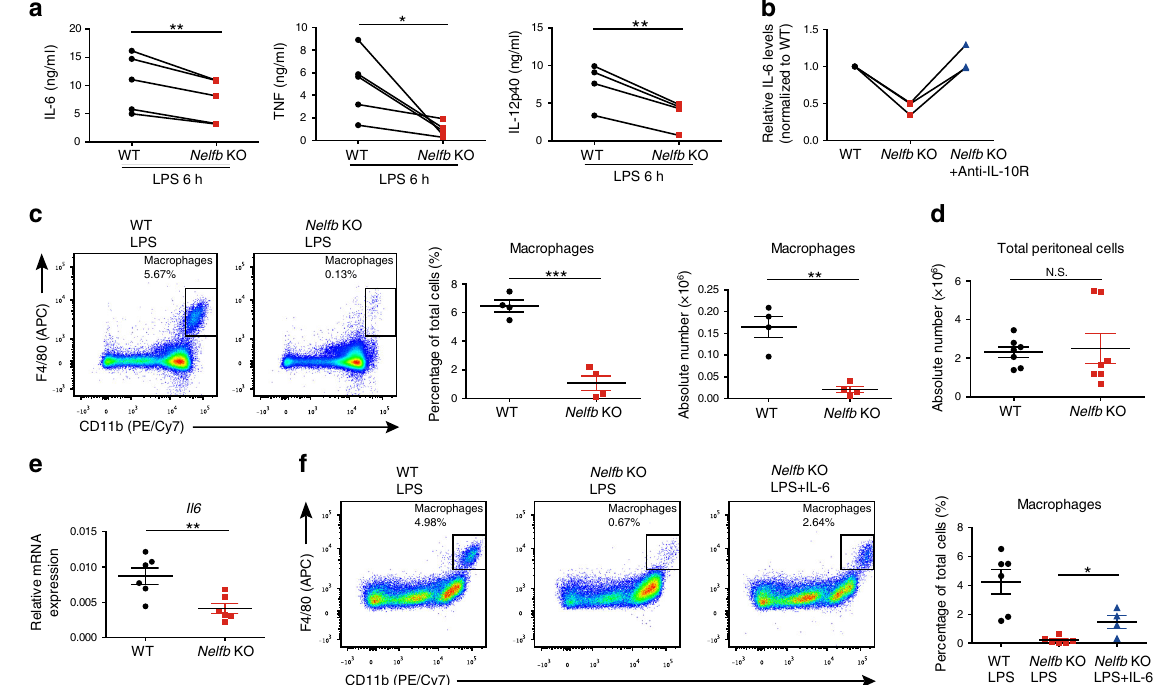
Fig. 7 NELF potentiates in fl ammatory responses secondary to constraining the production of IL-10. a ELISA for IL-6 ( n = 5, P = 0.0051), TNF ( n = 5, P = 0.0402) and IL-12p40 ( n = 4, P = 0.0061) protein levels in WT and Nelfb KO BMDM stimulated with LPS for 6 h. * P < 0.05, ** P < 0.01 by two-sided paired Student ’ s t test. b WT and Nelfb KO BMDM pretreated with 2 μ g/ml of anti-IL10R for 0.5 h, where indicated, were activated with LPS for 6 h. IL-6 levels in culture supernatants were measured by ELISA and shown as relative values normalized to levels in WT cells that were set as 1 in each independent experiment ( n = 3). c FACS analysis of the macrophage population (CD45 + CD11b + F4/80 + ) in peritoneal exudates of WT and Nelfb KO mice 9 h after intraperitoneal injection of LPS (100 ng/mouse). Representative FACS distribution (left) and cumulative ( n = 4) percentage (middle, P = 0.0002) as well as absolute numbers (right, P = 0.0014) are shown. d Cumulative data showing total peritoneal cell numbers from WT and Nelfb KO mice 9 h after